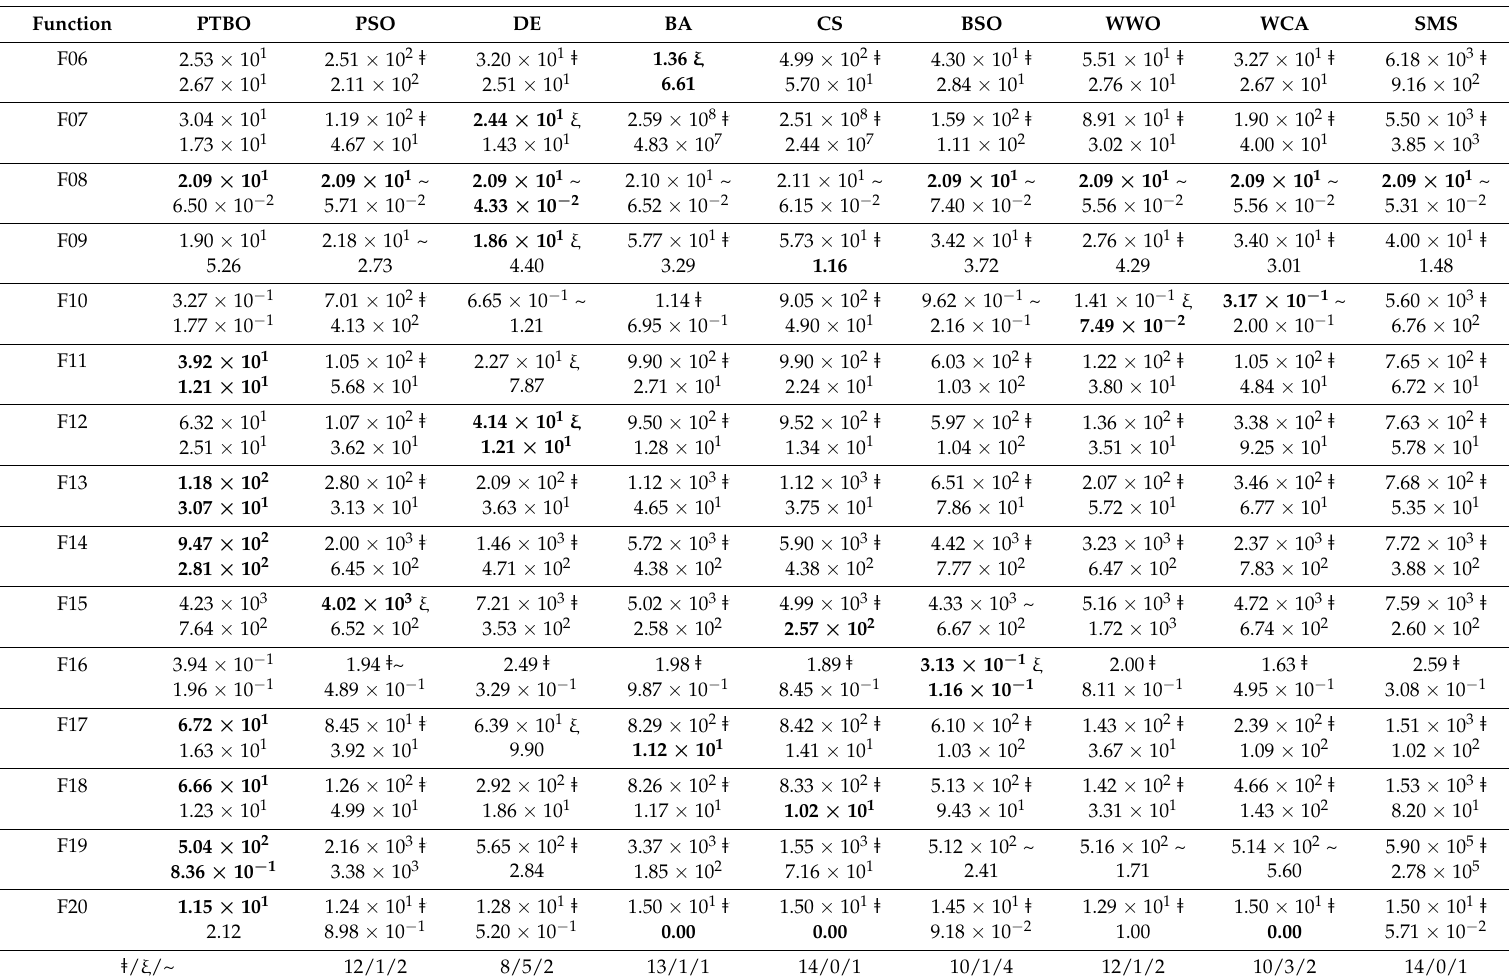
Table 9. The results of solution accuracy for the multimodal functions.